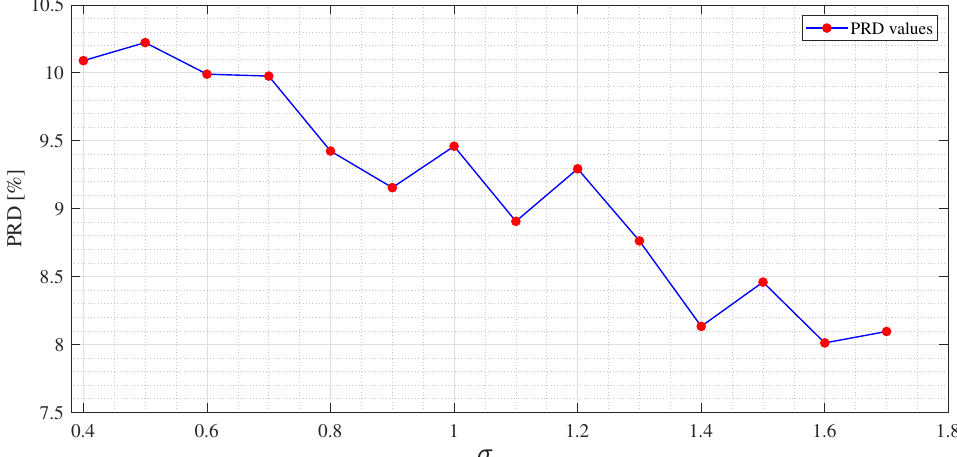
Figure 6. PRD values for several values of σ of SGPL1 for USR = 9 for the MIT-BIH arrhythmia database signal No. 122.